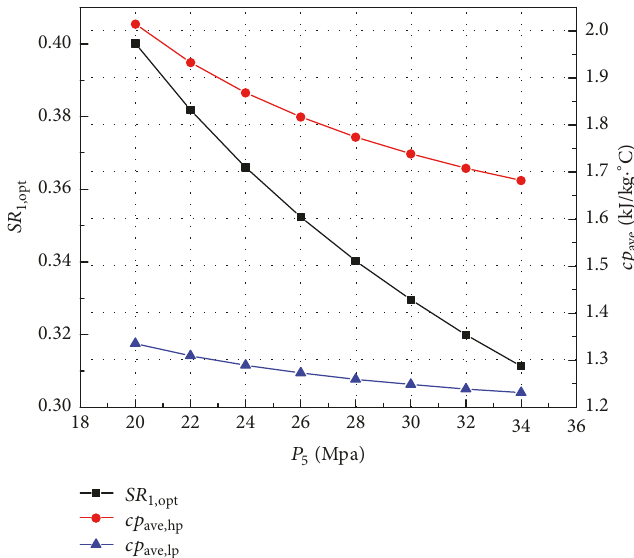
Figure 5: Effects of HPT inlet pressure on optimal SR 1 .